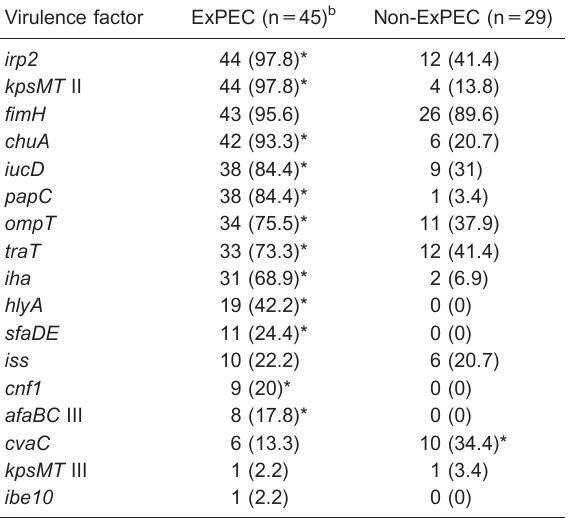
Table 2. Distribution of virulence factors according to the extraintestinal pathogenic Escherichia coli (ExPEC) status a